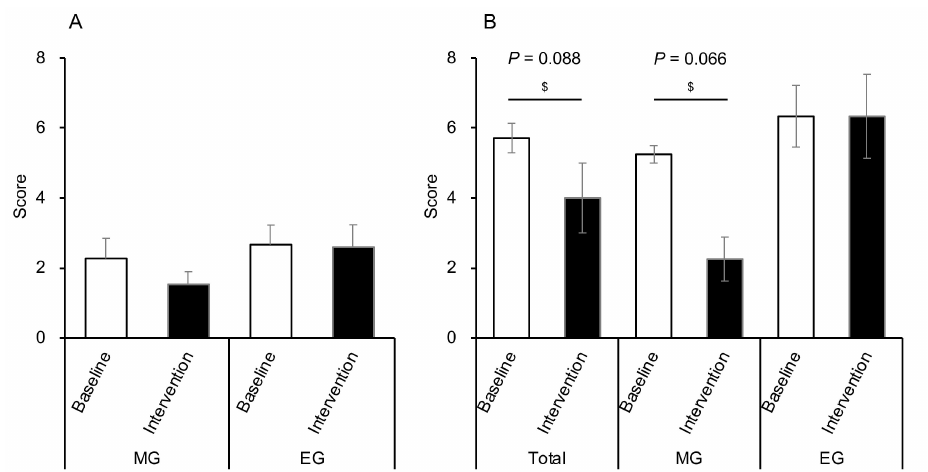
Figure 8. Changes in CAS before and after intervention in both groups. ( A ) Changes in CAS before and after intervention in all participants in both groups (MG: n = 15, EG: n = 15). ( B ) Changes in participants with constipation before and after the intervention (total: n = 7, MG: n = 4, EG: n = 3). Values are expressed as means and standard errors. $ p < 0.05 compared to the baseline level